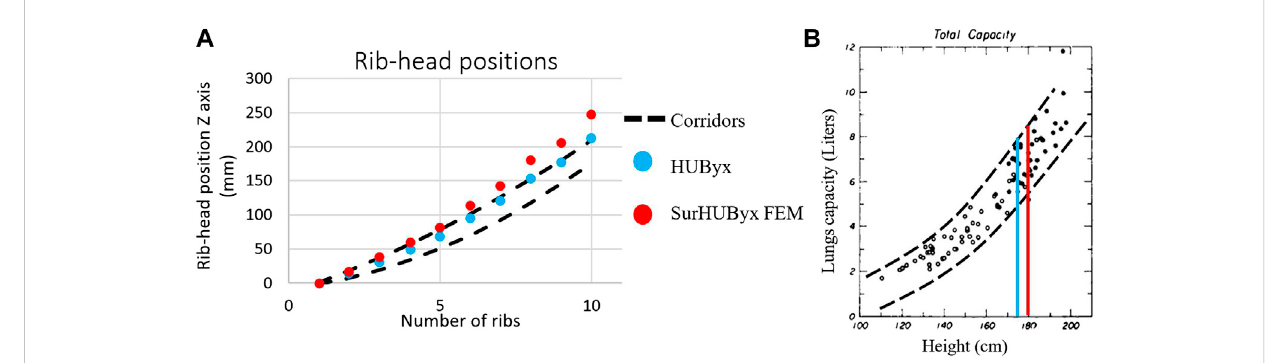
FIGURE 4 Comparison of rib-head positions of HUByx and SurHUBx within experimental corridors [28] (A) Relationship between height and lung volume [29] (B) .